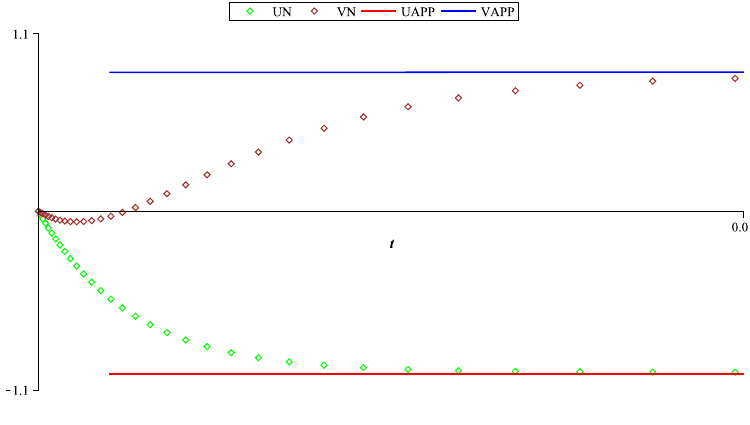
Figure 4. Inner numerical solution and approximate outer solutions given in [1] for Example 5.